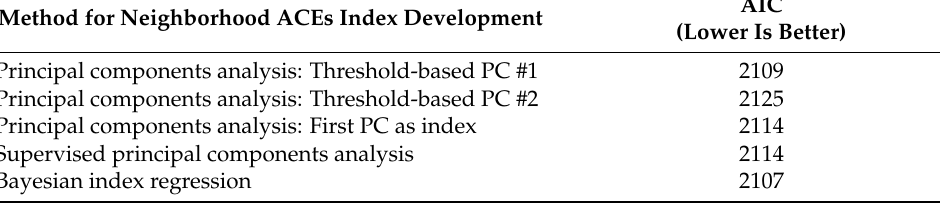
Table 2. Comparison of methods for development of neighborhood ACEs